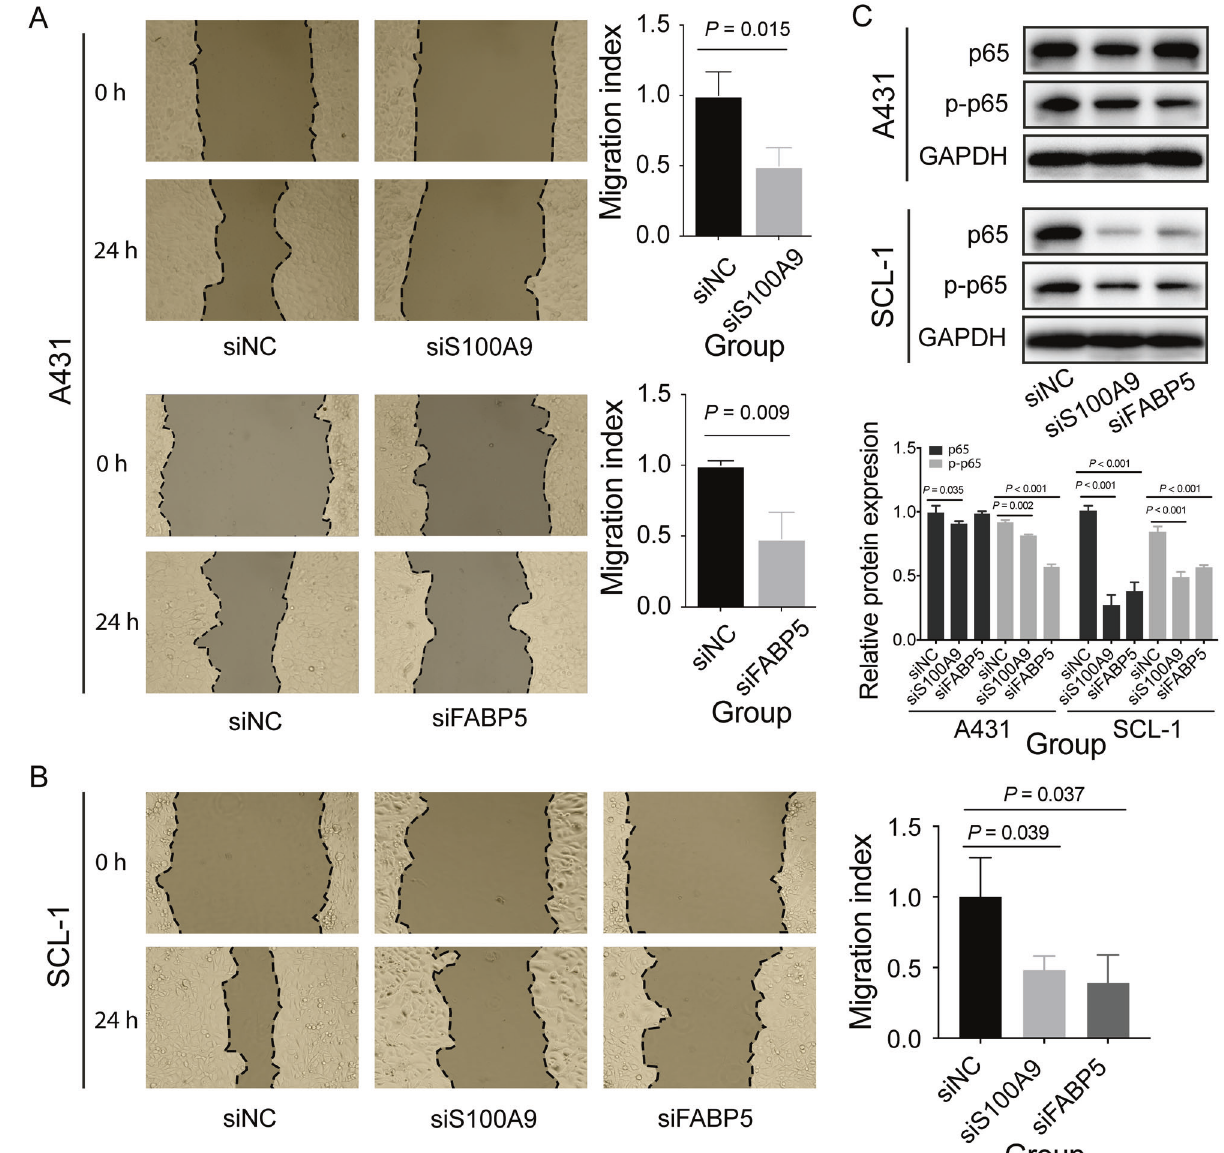
Fig. 7 Effect of S100A9 and FABP5 on cell migration and NF- κ B pathway. A , B The effect of S100A9 and FABP5 on cell migration and invasion were determined by wound-healing assay. C The effect of S100A9 and FABP5 on NF- κ B pathway were determined by western blot analysis. Data were presented as mean ± SD. siNC represents the siRNA negative control, and si S100A9 and si FABP5 represent the speci fi c S100A9 siRNA and FABP5 siRNA, respectively. The statistical method is the unpaired Student ’ s t